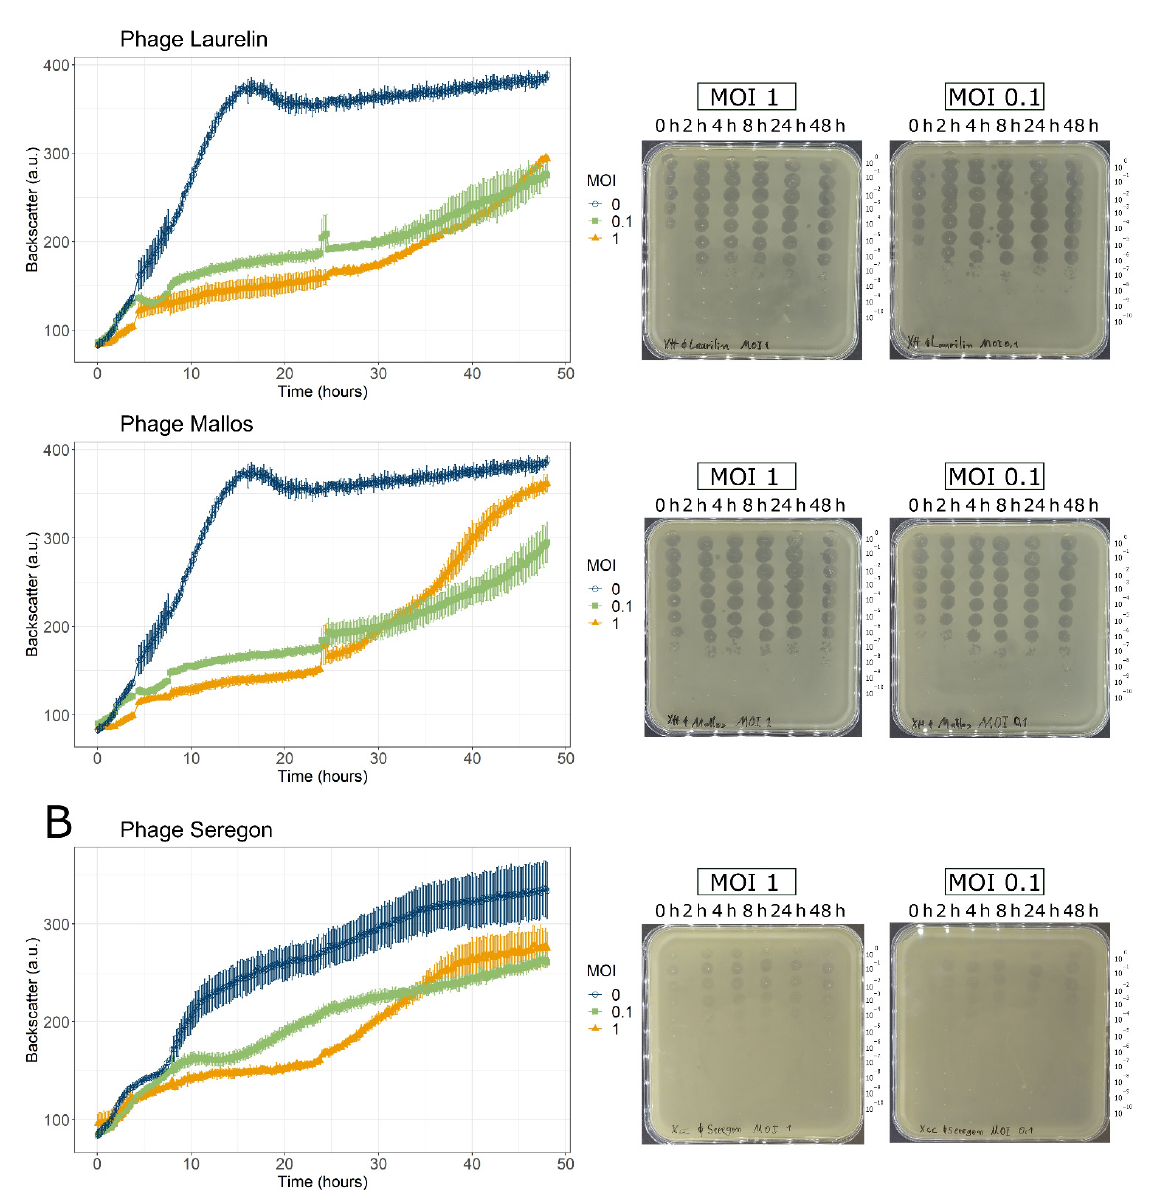
Figure 2. Infection curves of seven phages infecting Xtt ( A ) and Xcc ( B ). Full-grown overnight cultures of the host were adjusted to an OD 600 of 0.2 and phages at the corresponding multiplicity of infection (MOI) were added. The infection was performed as biological triplicates. Backscatter was measured over time (left panels), as well as phage titers (right panels). Plaques of phage Seregon have a turbid appearance and are, therefore, hardly visible (see Figure 1B).